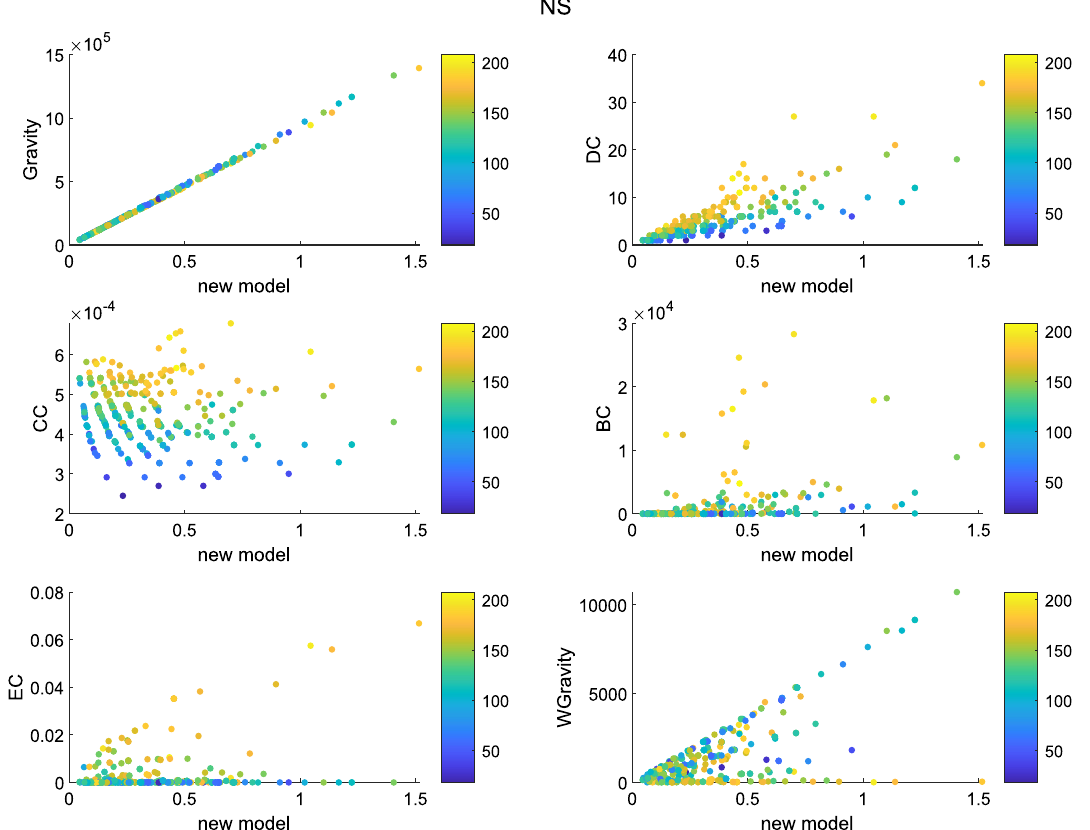
Figure 10. The figure describes the correlation between the new model and other methods in NS. Besides Gravity model and weighted gravity model, the new model shows positive correlation with